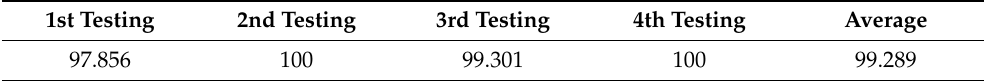
Table 2. Testing results of YOLOv3 on the combined multinational dataset. (Measure: mAP, unit: